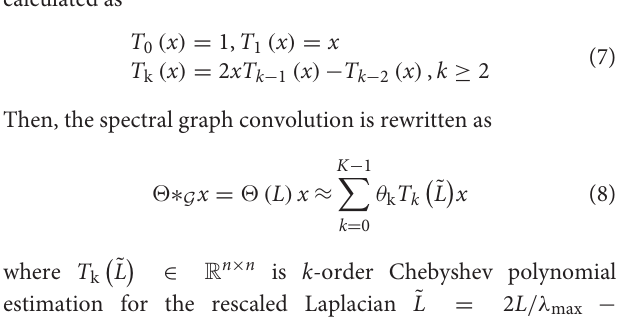
where graph Fourier basis U ∈ R n × n is the matrix of eigenvectors of the normalized graph Laplacian L = I n − D − 1 / 2 WD − 1 / 2